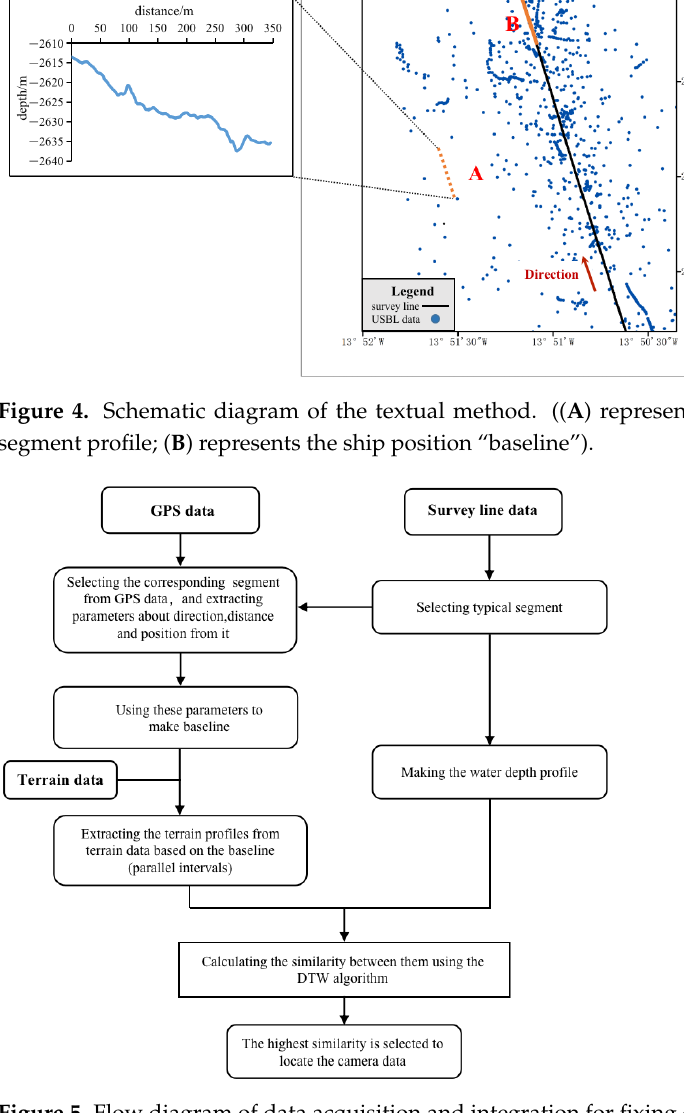
Figure 5. Flow diagram of data acquisition and integration for fixing of camera data.